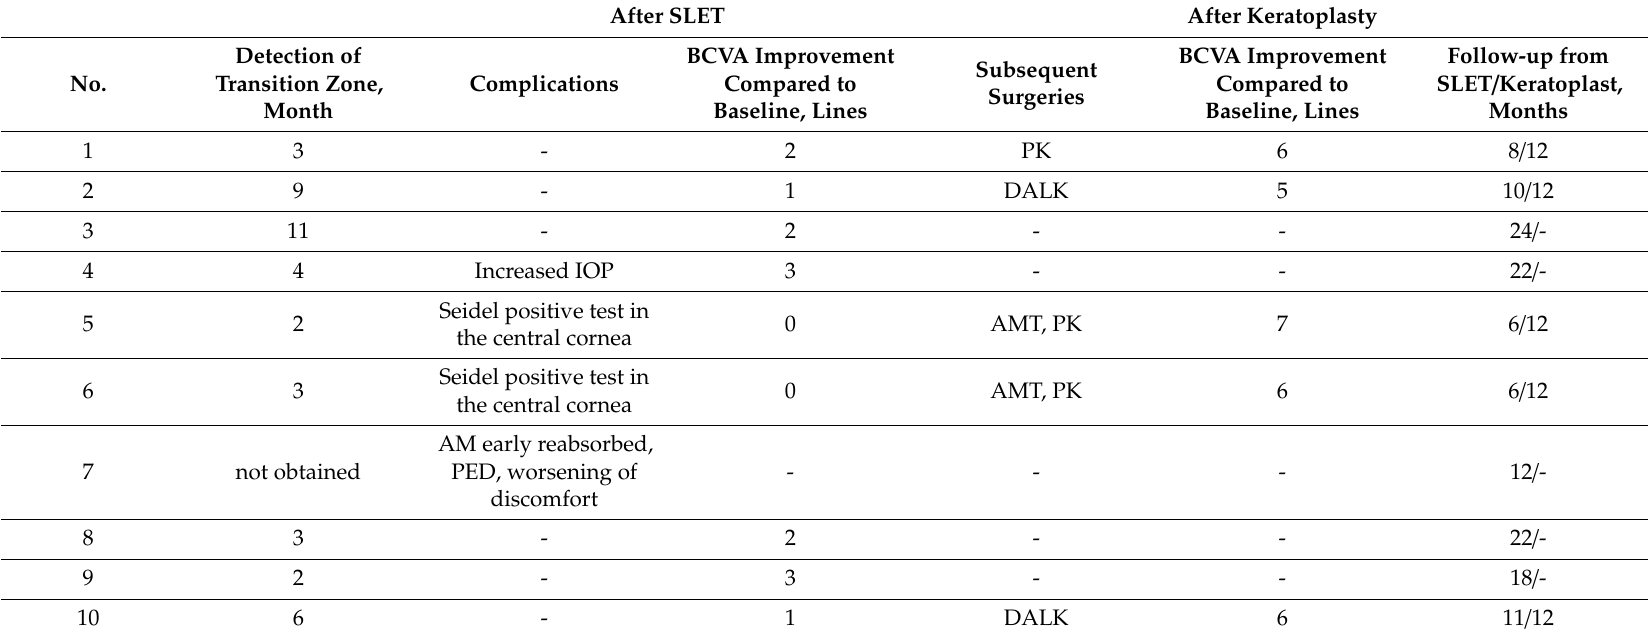
Table 2. Outcomes and complications after simple limbal epithelial transplantation (SLET) and keratoplasty. After SLET After